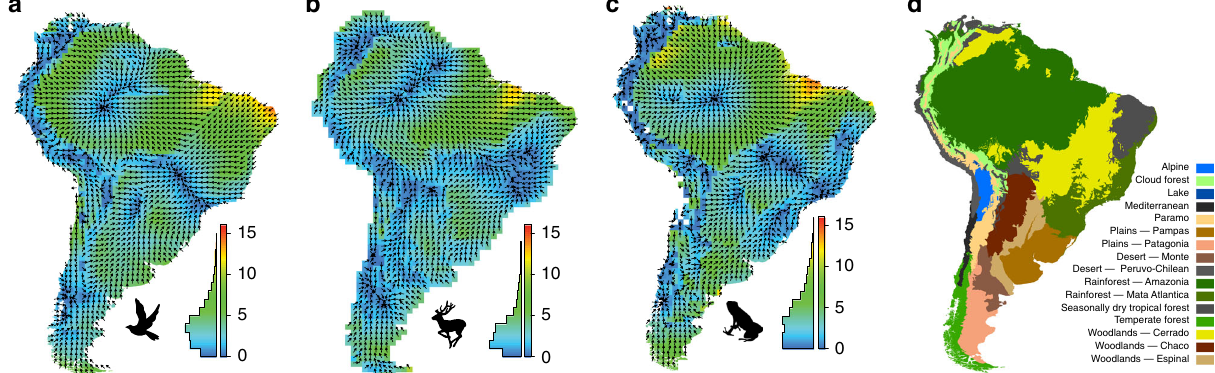
Fig. 3 ADF symmetry diagrams for South American birds, mammals, and amphibians and major vegetation biomes. Arrows indicate the major axis of asymmetry of the ADFs for individual cells ( n = 1689). The degree of asymmetry is indicated by a color scale (green through red colors represent more asymmetrical ADFs). This fi gure summarizes the vector arrows shown in Fig. 2 for all grid cells on the continent. Histograms show the distribution of vector lengths. The panels show a birds, b mammals, c amphibians, and d vegetation ecoregions. ADF symmetry diagrams using different cutoff values for the central ADF region are shown in Supplementary Figs. 3 and 5.). The map in d was provided by Tiina Särkinen, originally based on the map of the World ’ s ecoregions developed by the WWF (ref. 48 ; under CC BY 4.0 license: https://creativecommons.org/licenses/by/4.0/).